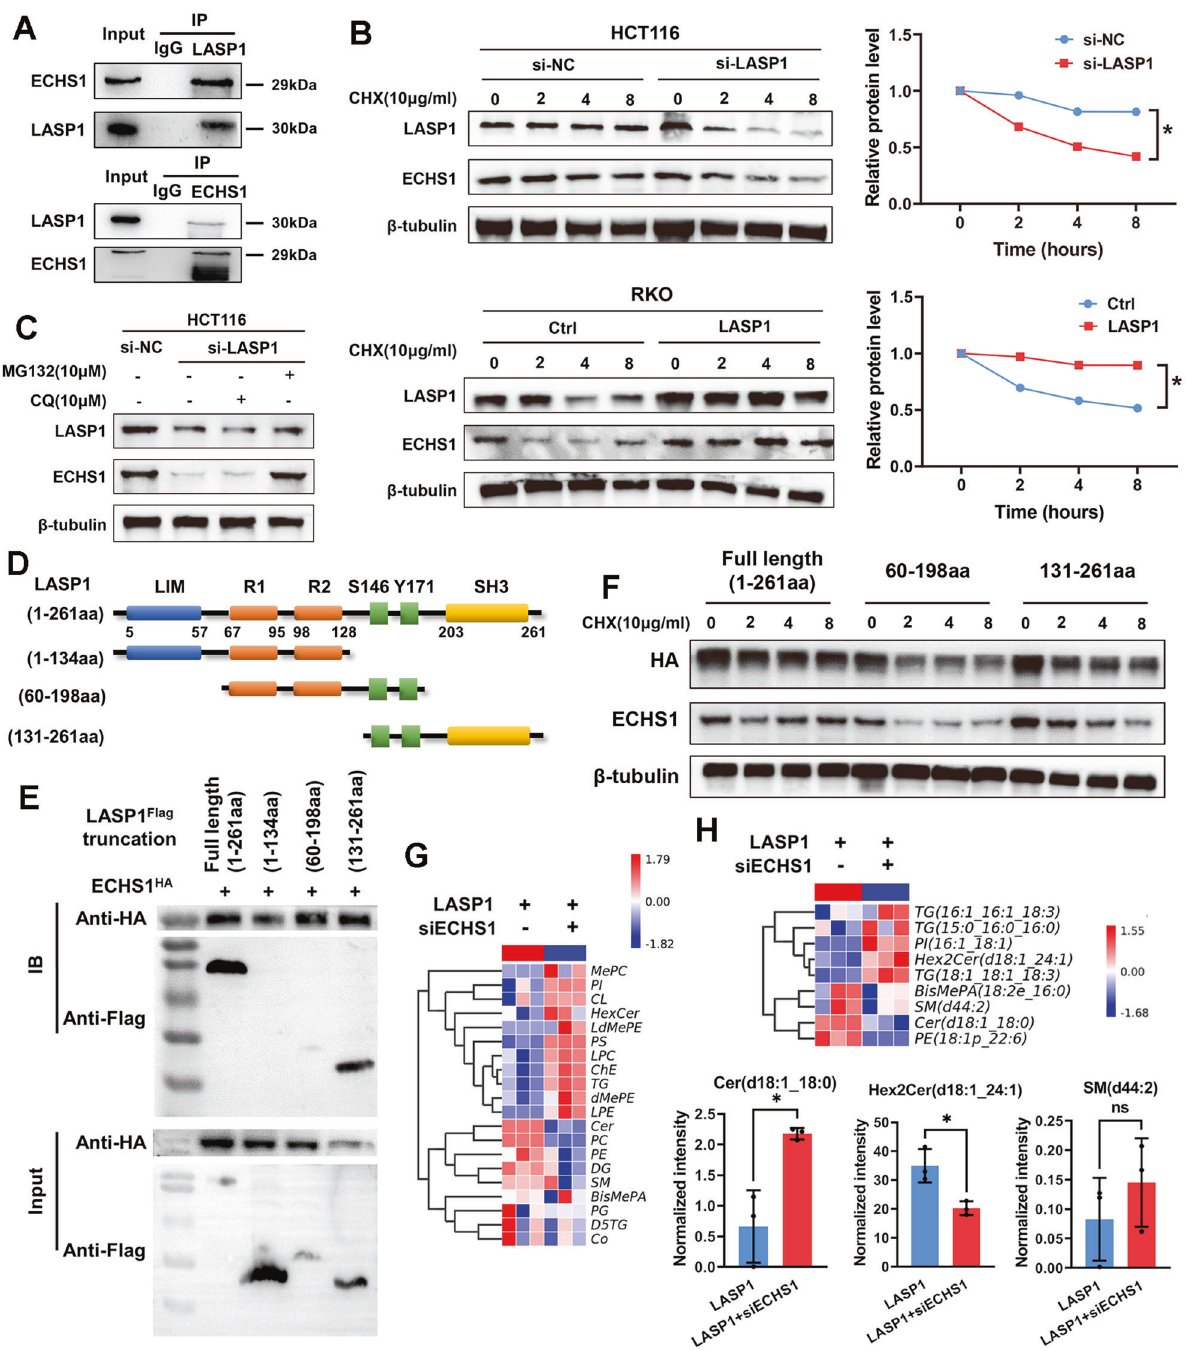
Fig. 2 ECHS1 is essential for LASP1-mediated sphingomyelin-metabolism imbalance by interacting with SH3 domain of LASP1 in CRC. A Immunoprecipitation-assay analysis of endogenous interaction between ECHS1 and LASP1 in SW480 cells. B Western blot assay of LASP1 and ECHS1 protein and quanti fi cation of ECHS1 relative level at the indicated time in HCT116 cells transfected with siLASP1 or siNC (upper fi gure) or RKO cells transfected with LV-LASP1 or LV-Ctrl (lower fi gure) after CHX treatment to block protein synthesis. C Western blot assay of the level of LASP1 and ECHS1 protein with application of chloroquine (10uM) or MG132 (10uM) after 8 h. D Schematic presentation of LASP1 structure features. The structures of truncated LASP1 are listed behind those of the full-length proteins. E Western blotting results indicate the binding domain of ECHS1 and LASP1 in 293 T cells. F Western blot assay of HA and ECHS1 protein in 293 T cells transfected with plasmid HA-LASP1 full length (1 – 261aa), HA-LASP1 (60 – 199aa), or HA-LASP1(131 – 261aa) after CHX treatment to block protein synthesis. G Heatmap of the LC – MS assay for RKO-LASP1 and RKO-LASP1 transfected with siECHS1 cells. H Heatmap and histogram of depicting the differentially expressed lipomics for RKO-LASP1 and RKO-LASP1 plus siRNA-ECHS1